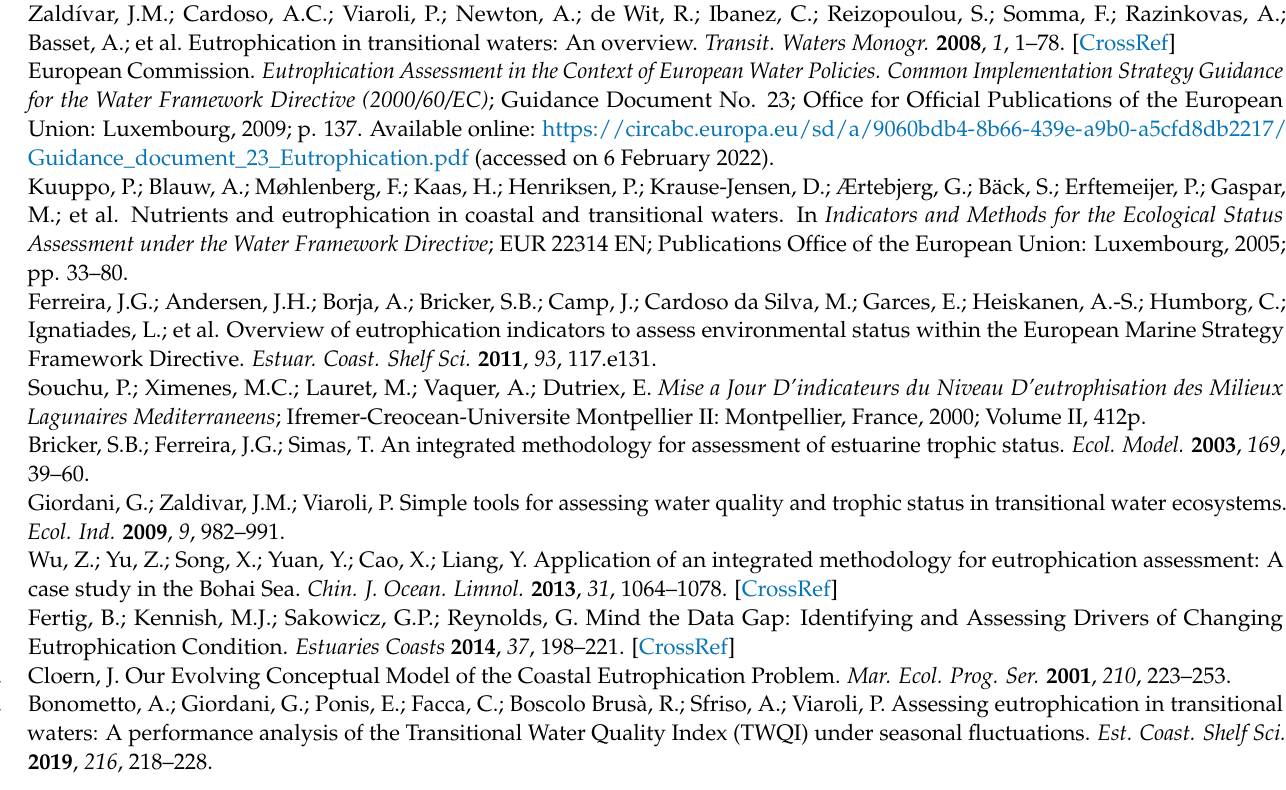
Table S2. TWEAM data input and